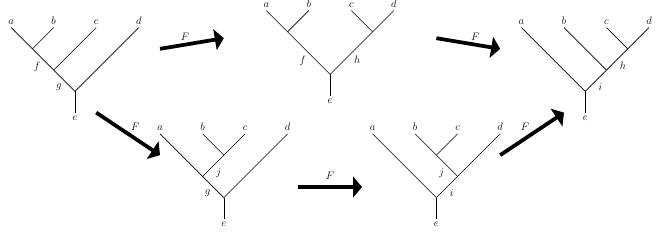
Figure 1 . Pentagon equation w.r.t. the fusion space ( V abcd